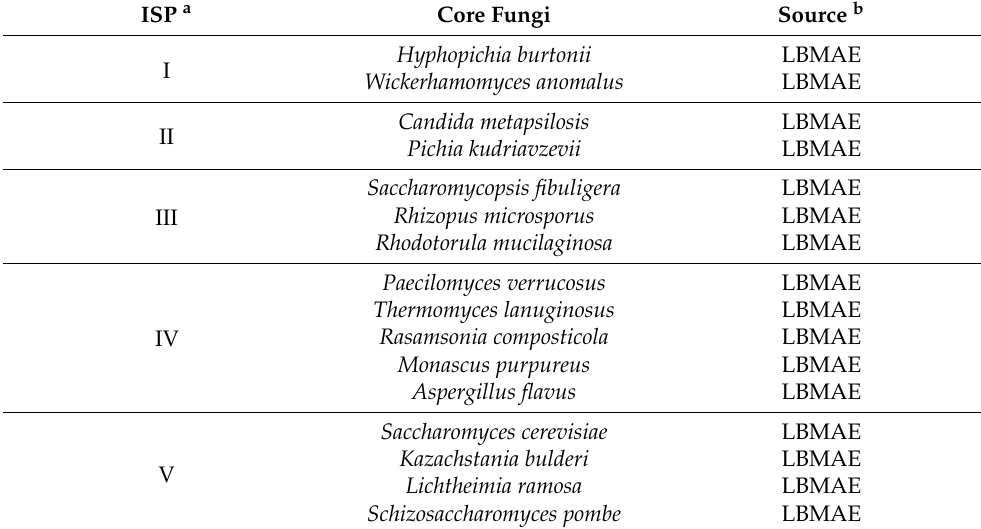
Table 2. Five ISPs and 16 core